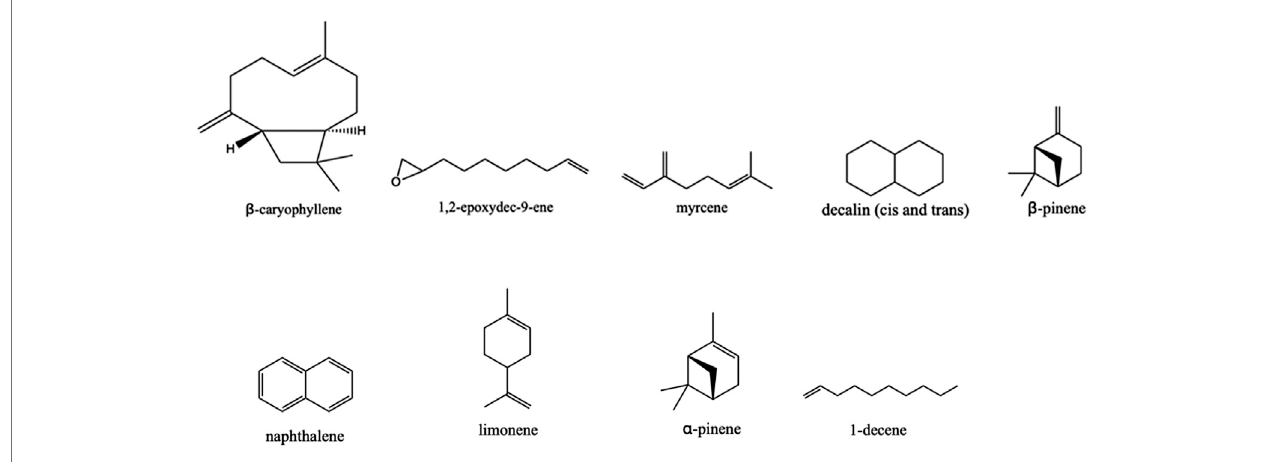
FIGURE 2 | Structures of the high SOA yield precursor compounds: top row > 20%, bottom row 4 –